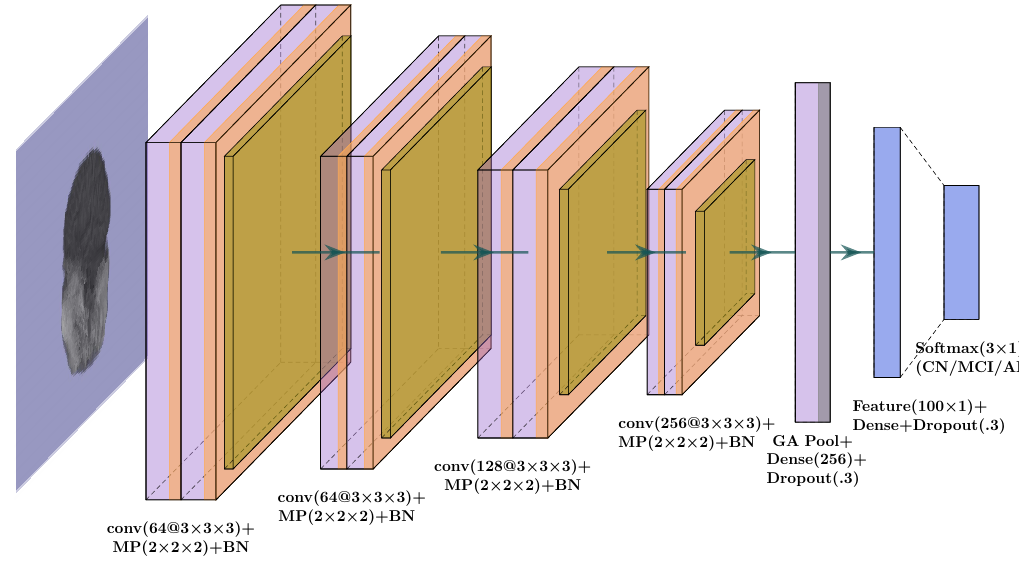
Figure 2. Convolution neural network architecture used for the whole-brain structure. From the penultimate dense layer, 100 neurons are extracted as the